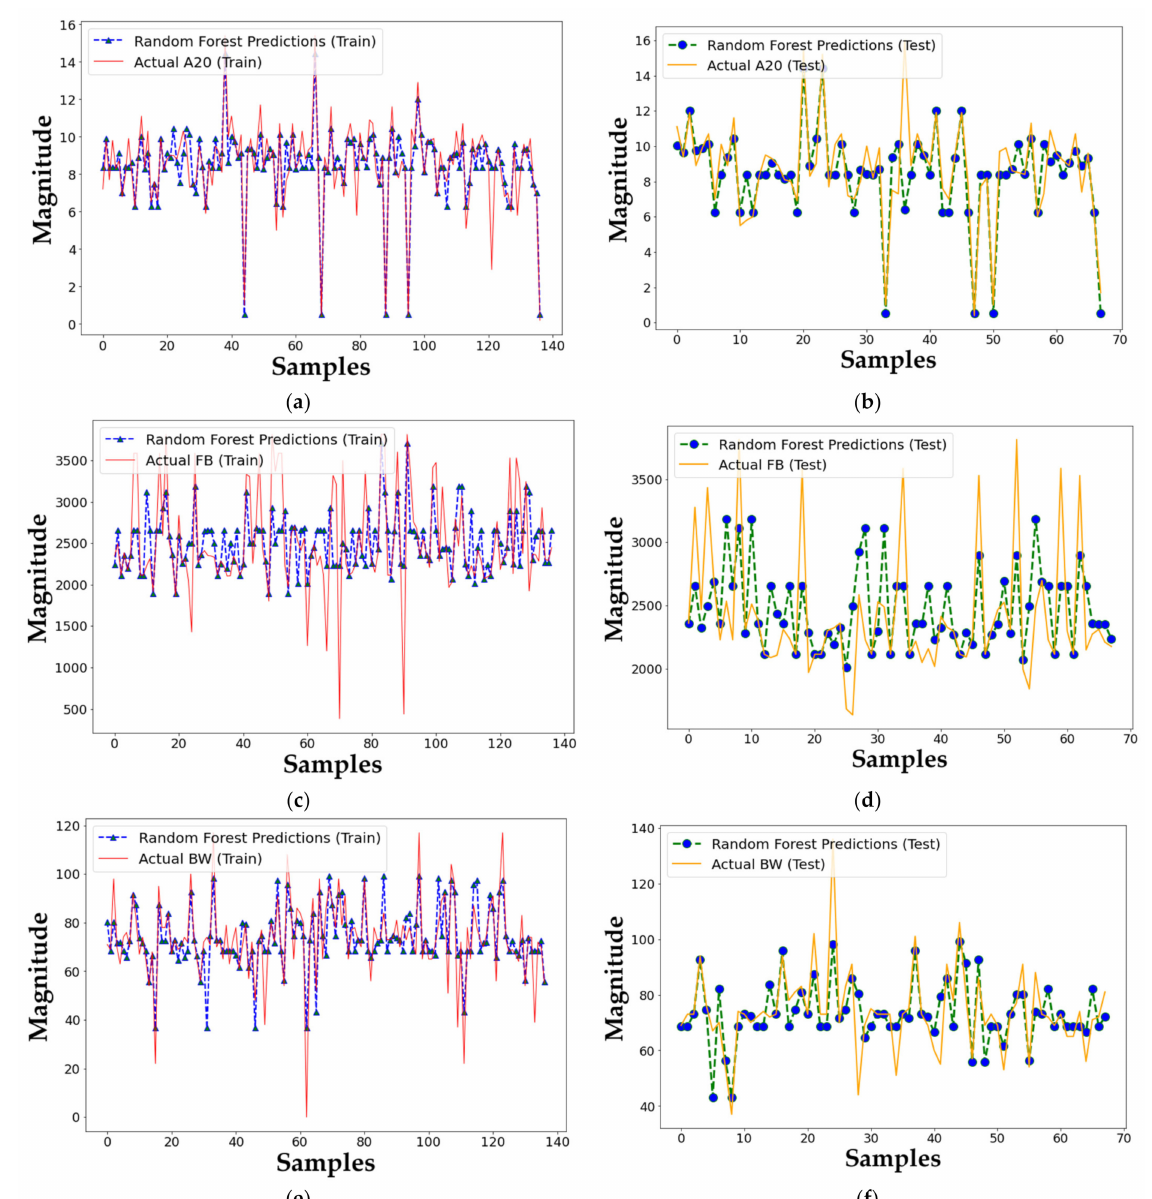
Figure 11. Description of the performance of Random Forest Regression in modelling the digital twins of the alloy based on A20 ( a , b ); FB ( c , d ); BW ( e , f ) in the presence of all inputs including heating, QT, PT, and Pt; ( a , c , e ): Train and ( b , d , f ):